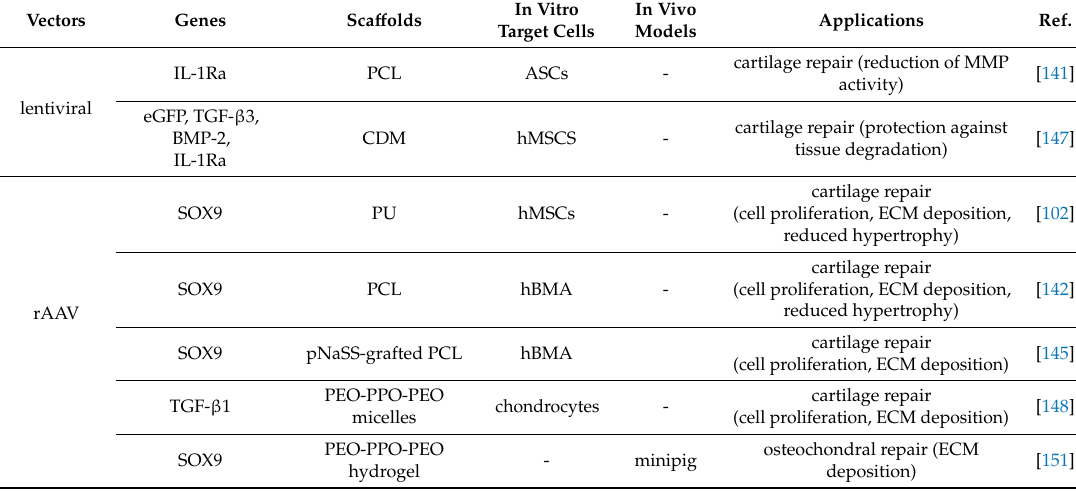
Table 4. Sca ff old-mediated viral gene